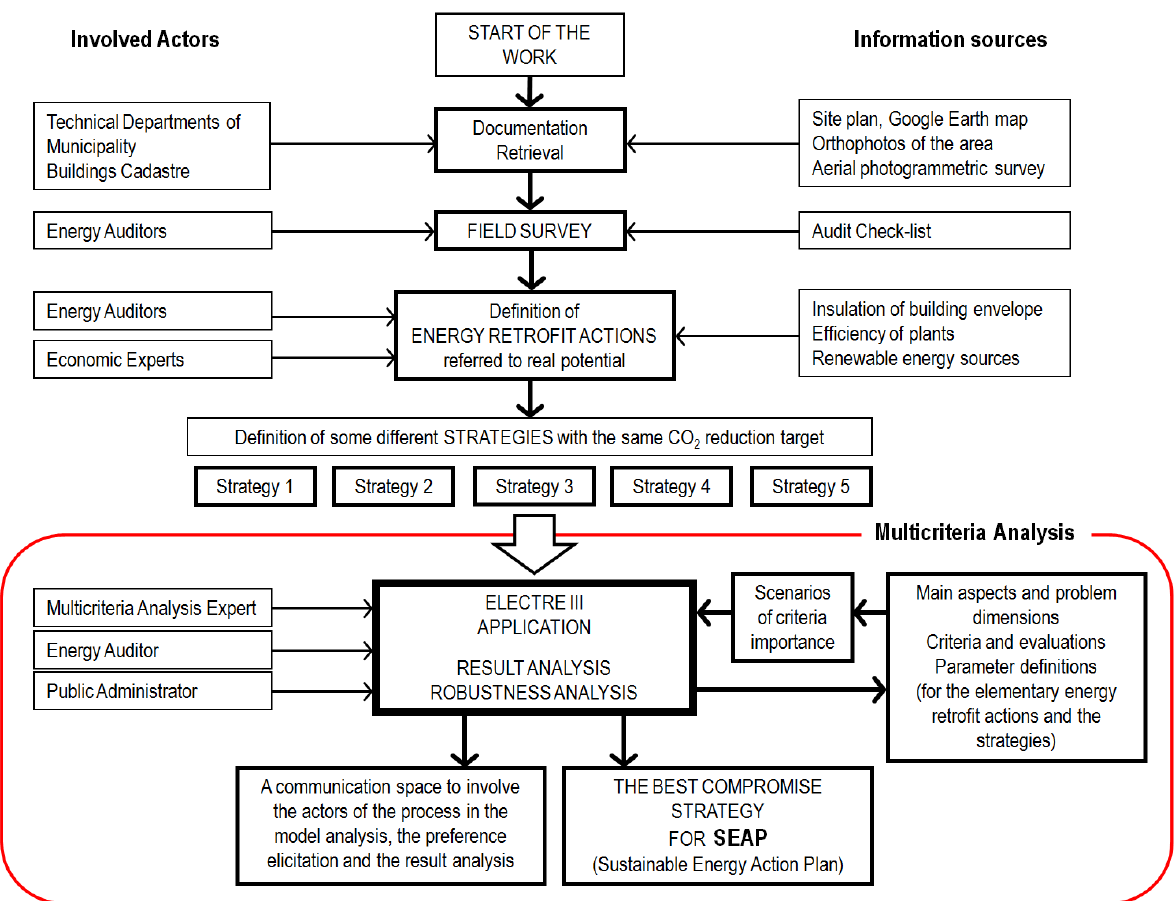
Figure 1. Flow diagram of the